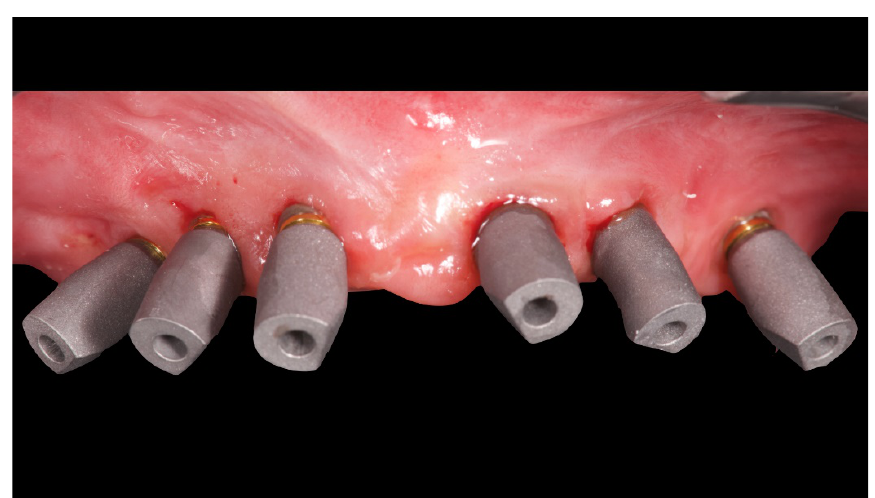
Figure 6. OT Equator used as abutment for the fixed prosthesis according to the OT Bridge system.